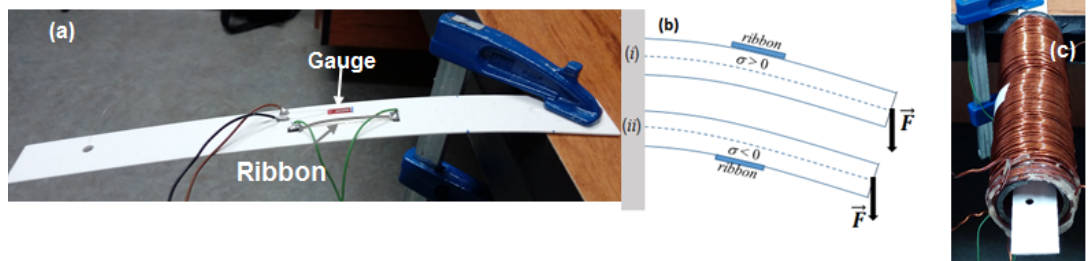
Figure 1. ( a ) Experimental set-up for applying stresses; ( b ) scheme of the applied mechanical